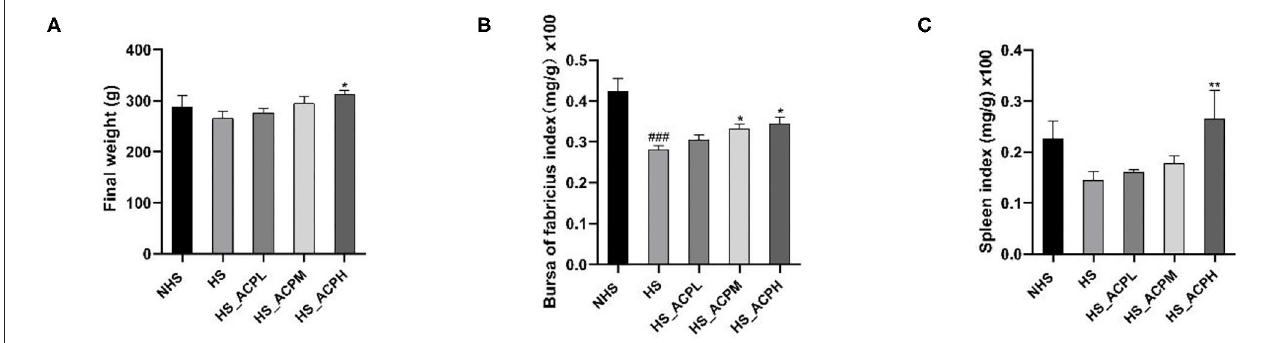
FIGURE 1 | Effects of Abrus cantoniensis Hance (ACP) supplementation on body weight and immune organ indices. (A) Final weight, (B) The bursa of Fabricius index, (C) The Spleen index. Data are presented as the mean ± SEM. ### p < 0.001 compared with the normal temperature control (NHS) group; * p < 0.05, ** p < 0.01 compared with the heat stress (HS)